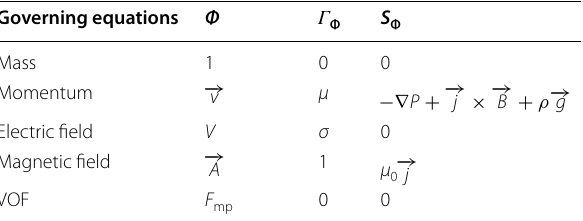
Table 1 The governing equations